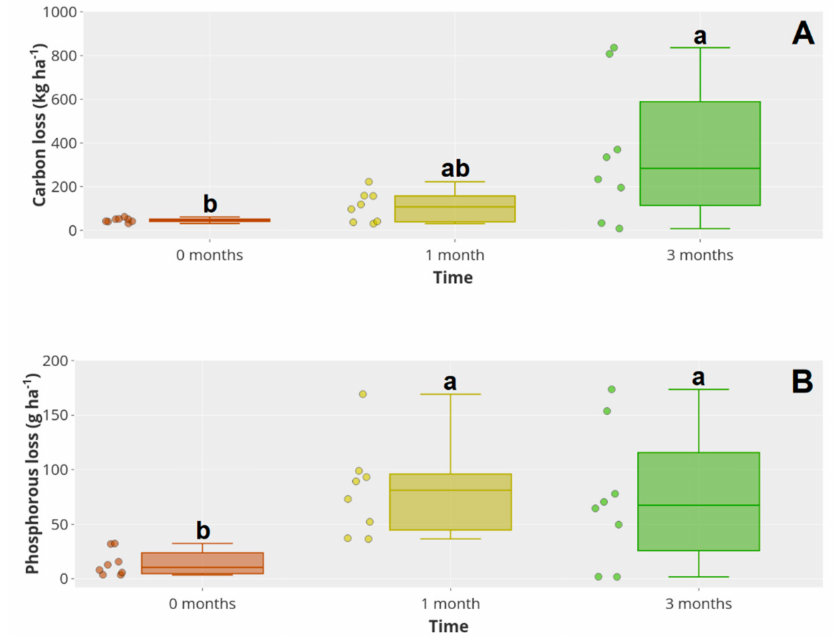
Figure 6. Nutrient loss during the rainfall simulation experiments: ( A ) carbon loss and ( B ) phosphorus loss distribution according to the time after tillage. Upper hanging bar (maximum), lower hanging bar (minimum), upper box line (quartile 3), line (median), and lower box line (quartile 1). Di ff erent lower-case letters represent significant di ff erences between treatments ( p < 0.05). Dots next to a boxplot represent measured